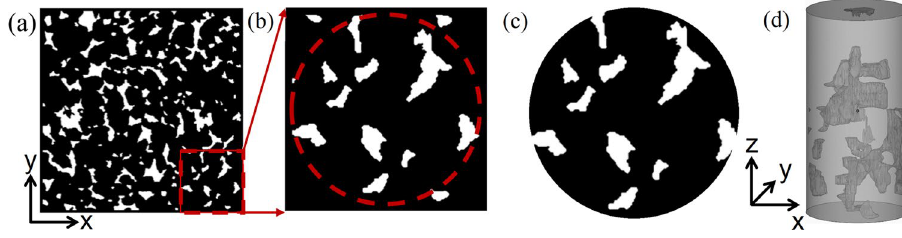
Fig. 3 Construction of digital Berea sandstone model with amplified pores. a – c Extraction of discontinuous pores in sandstone; d Digital